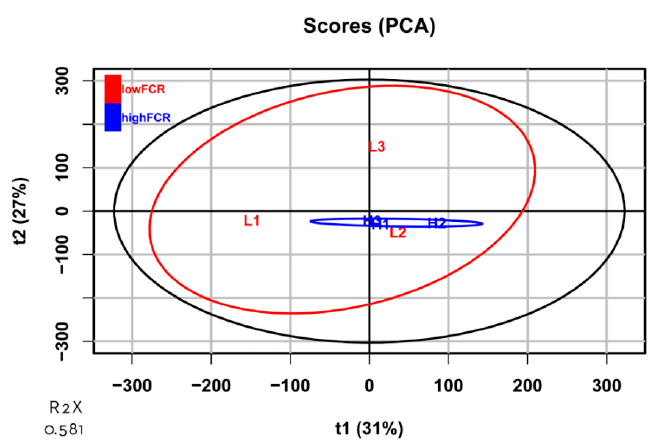
Figure 2. Principal component analysis (PCA) plot of the transcripts identified in high- and low-FCR samples. The ellipses represent 95% confidence intervals for each group. No outliers were observed. The abscissa and ordinate each represent a principal component, and the percentage represents the amount of variation between samples. R2X represents the accumulated variance contribution rate.